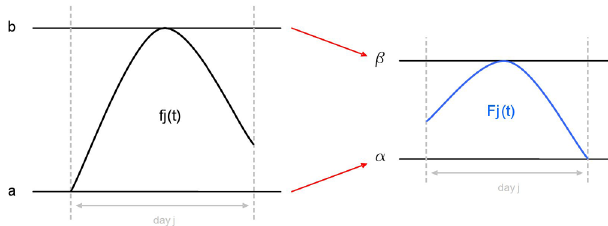
Fig. 2. Interpolation